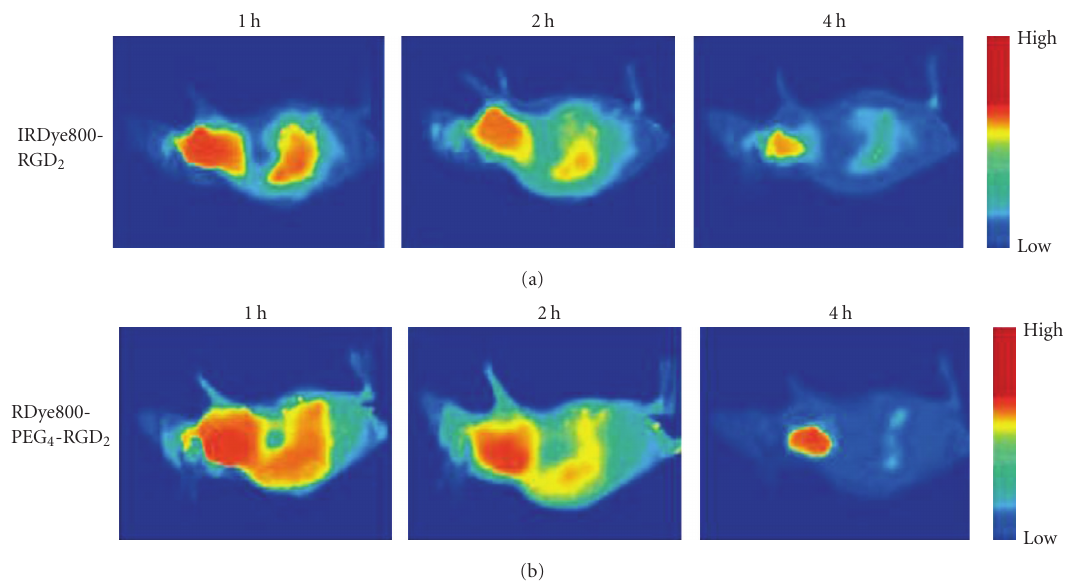
Figure 4: In vivo fluorescence imaging of U87MG tumor-bearing nude mice at 1, 2, and 4 hours after intravenous injection of 0.5 nmol IRDye800-RGD2 or IRDye800-PEG4-RGD2. Fluorescence signal from IRDye800 is pseudocolored (data from Liu et al.